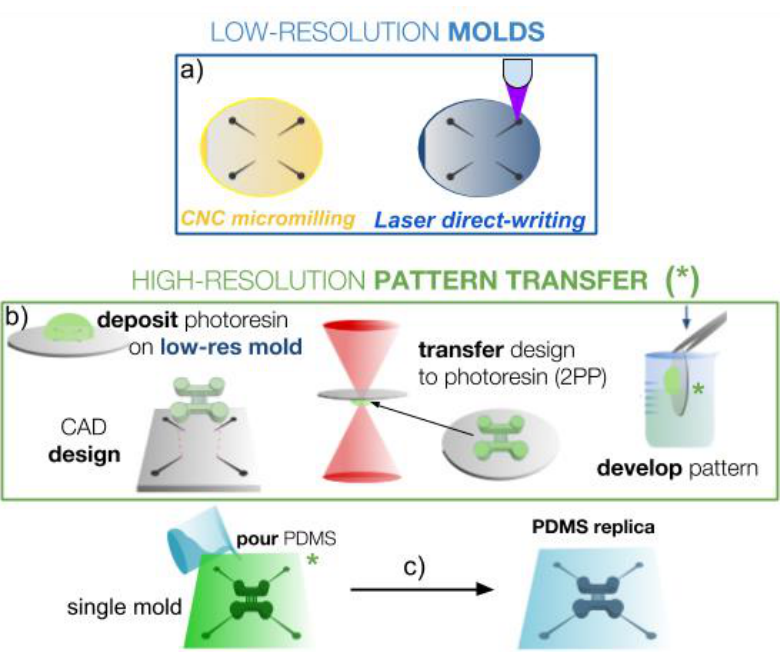
Figure 3. Micro–macro process using a single mold with both low-resolution and high resolution pattern transfer. ( a ) First, a low-resolution mold is made with CNC micromilling or laser-direct writing on a substrate compatible with the 2-photon laser polymerization (2PP) process. ( b ) Then a computer-aided design (CAD) containing microfeatures is transferred directly to the previous mold by 2PP to a compatible photoresin, developed and rinsed. ( c ) Finally, the single mold is used for the REM technique to obtain the final PDMS replica with macro- and micro-patterns on it.